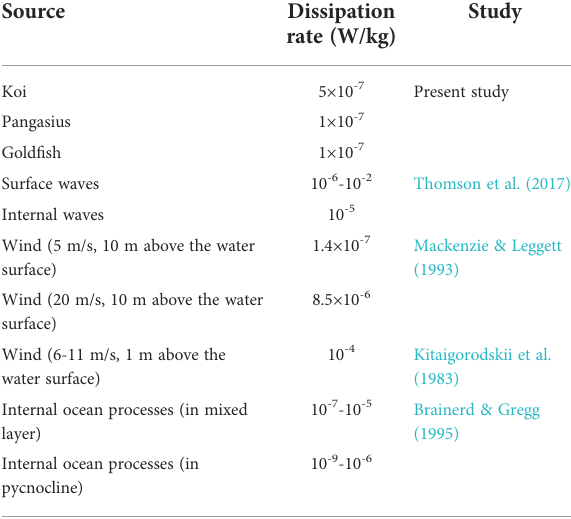
TABLE 5 Dissipation rates associated with the fi sh schools (at their natural abundances and at a water temperature of 24°C) in the present study and those of various physical